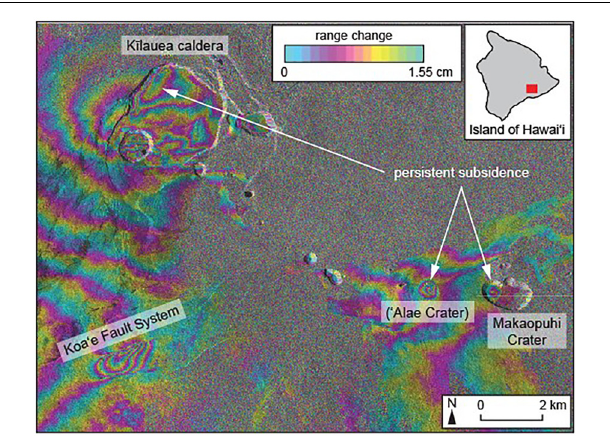
FIGURE 5 | Cosmo-SkyMed interferogram spanning April 2, 2012 – March 19, 2014 and showing deformation of K¯ılauea’s summit area and upper/middle East Rift Zone. Isolated areas of subsidence in the East Rift Zone at ‘Alae and Makaopuhi Craters are due to cooling of lava that filled those craters during the 1969–1974 Mauna Ulu eruption. A similar origin is expected for subsidence in the north part of K¯ılauea caldera, where a lava lake existed in the 1800s. Localized fringes in the Koa’e fault system are due to a pair of ∼ M 3.5 earthquakes on June 4–5,